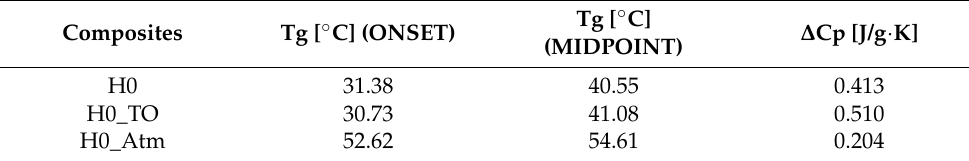
Figure 9. Thermogram of TGA ( a ) and DSC ( b ) and ( c ) for sample H0 before aging, after thermo- oxidative aging (H0_TO), and after atmospheric aging (H0_Atm). Table 8. Thermal properties of H0 samples before and after